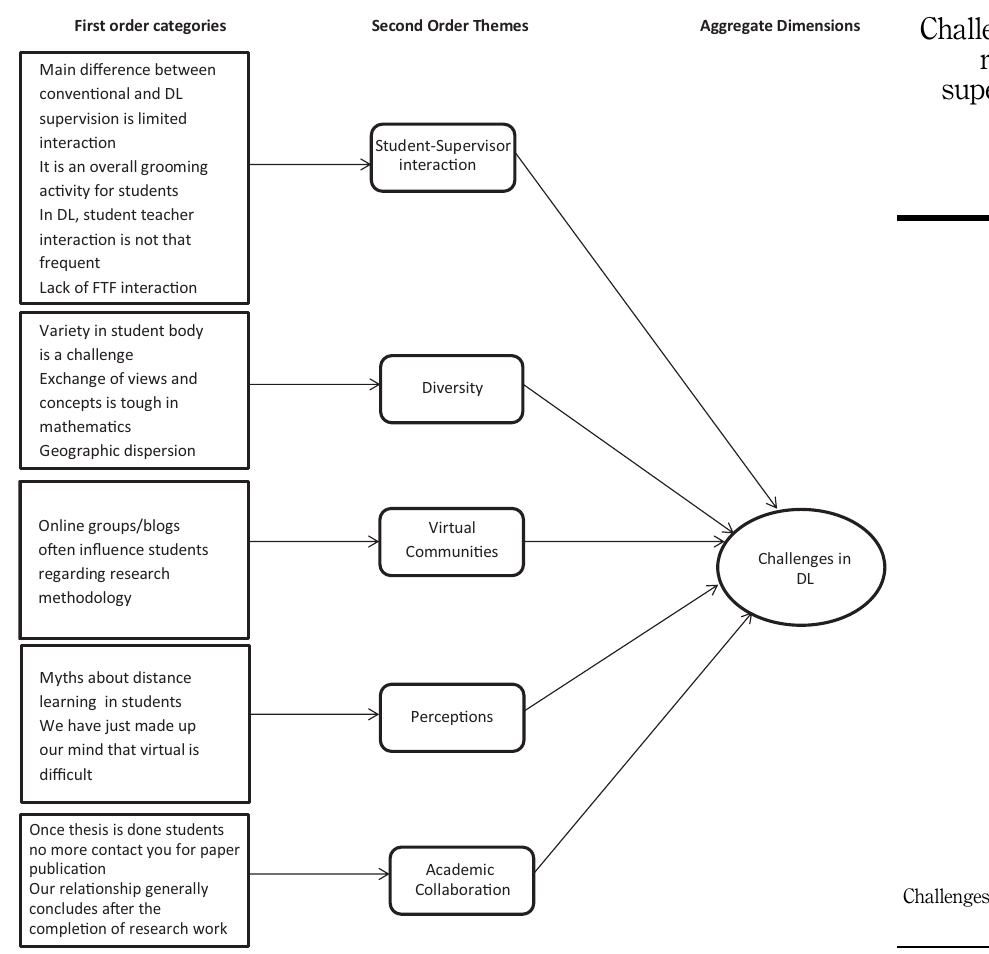
Figure 2. Challenges in